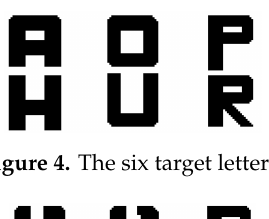
Figure 4. The six target letters.